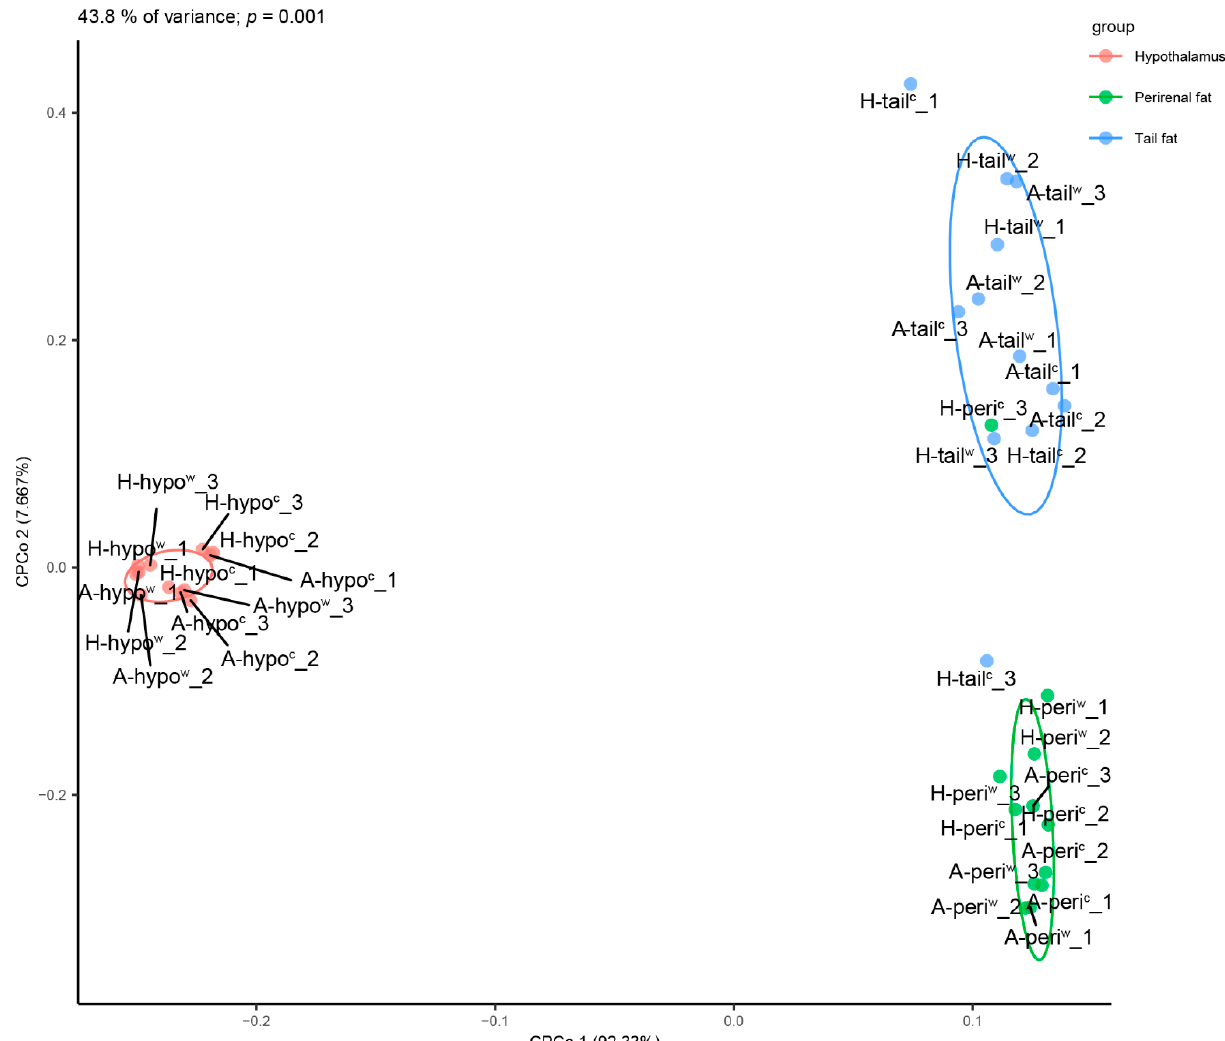
Figure 2. Constrained PCoA plot of Bray–Curtis distances constrained by global gene FPKM (48.3% of variance explained, p = 0.001; n = 36). Each point corresponds to a different sample, and each color represents a type of tissue. The percentage of variation indicated in each axis corresponds to the percentage of the total variance explained by the projection. A-hypo c : hypothalamus tissue of − 5 °C Altay lambs; H-hypo c : hypothalamus tissue of − 5 °C Altay lambs; A-hypo w : hypothalamus tissue of 20 °C Altay lambs; H-hypo w : hypothalamus tissue of 20 °C Hu lambs. A-peri c : perirenal fat tissue of − 5 °C Altay lambs; H-peri c : perirenal fat tissue of − 5 °C Altay lambs; A-peri w : perirenal fat tissue of 20 °C Altay; H-peri w : perirenal fat tissue of 20 °C Hu lambs. A-tail w : tail-fat tissue of − 5 °C Altay lambs; H-tail c : tail-fat tissue of − 5 °C Altay lambs; A-tail w : tail-fat tissue of 20 °C Altay lambs; H-tail w : tail-fat tissue of 20 °C Hu lambs.